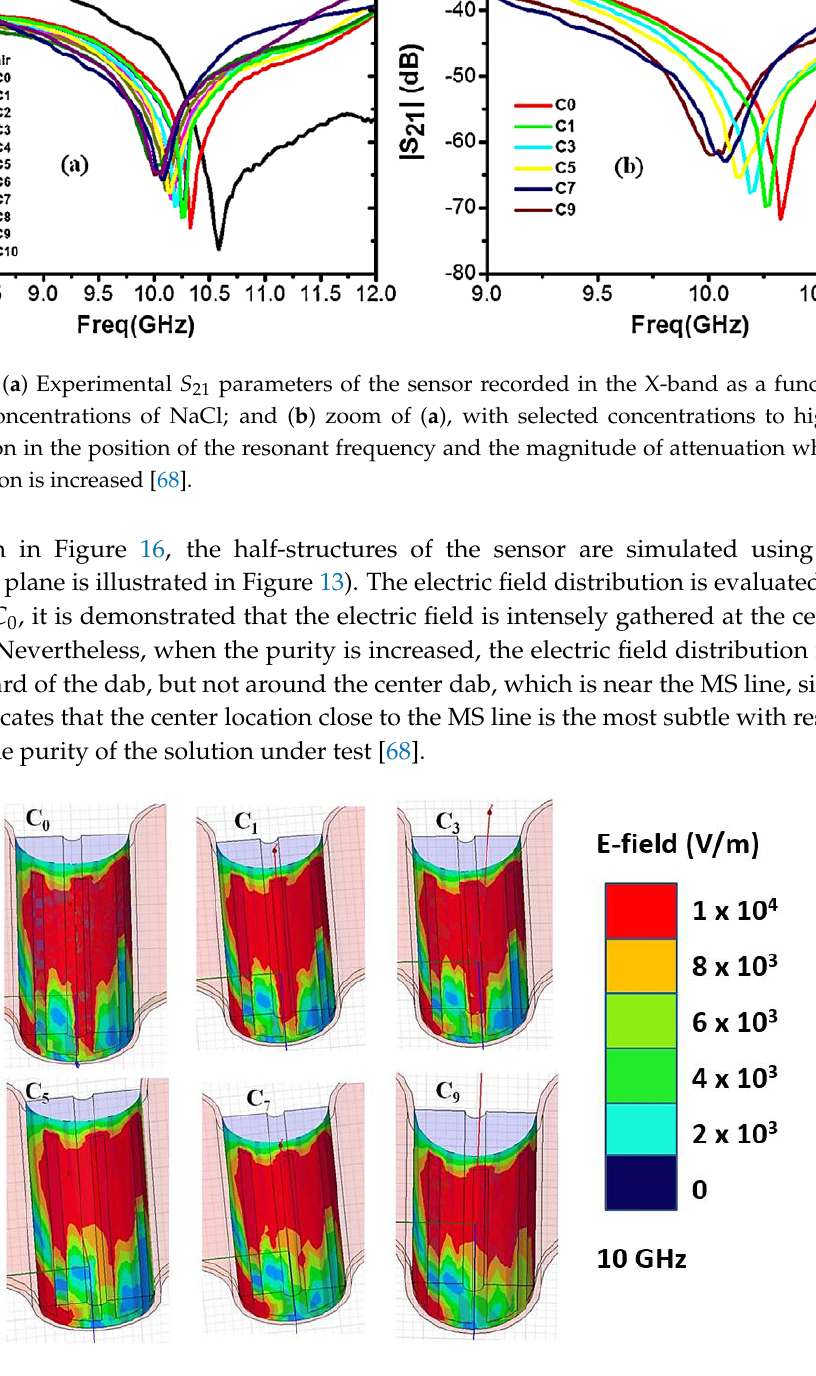
Figure 16. Electric field (E-field) distribution as a function of different NaCl-water concentrations calculated inside a symmetric half-structure of the sensor [68].